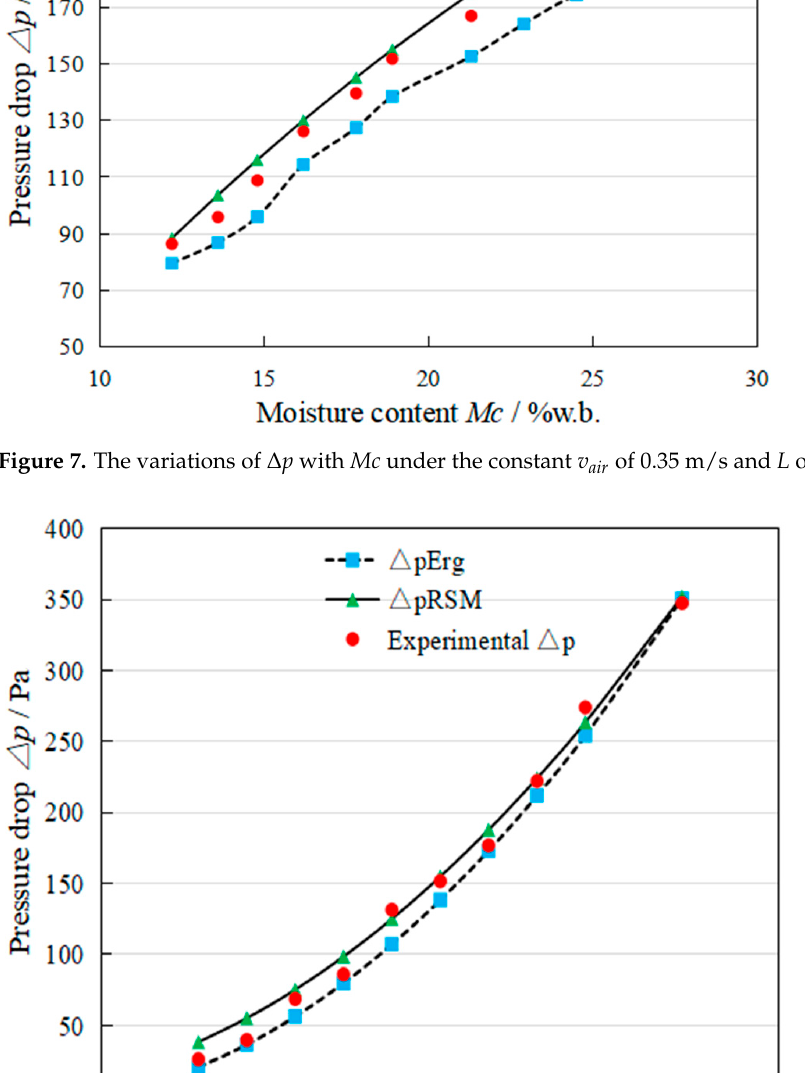
Figure 7. The variations of Δ p with Mc under the constant v air of 0.35 m/s and L of 0.5 m.